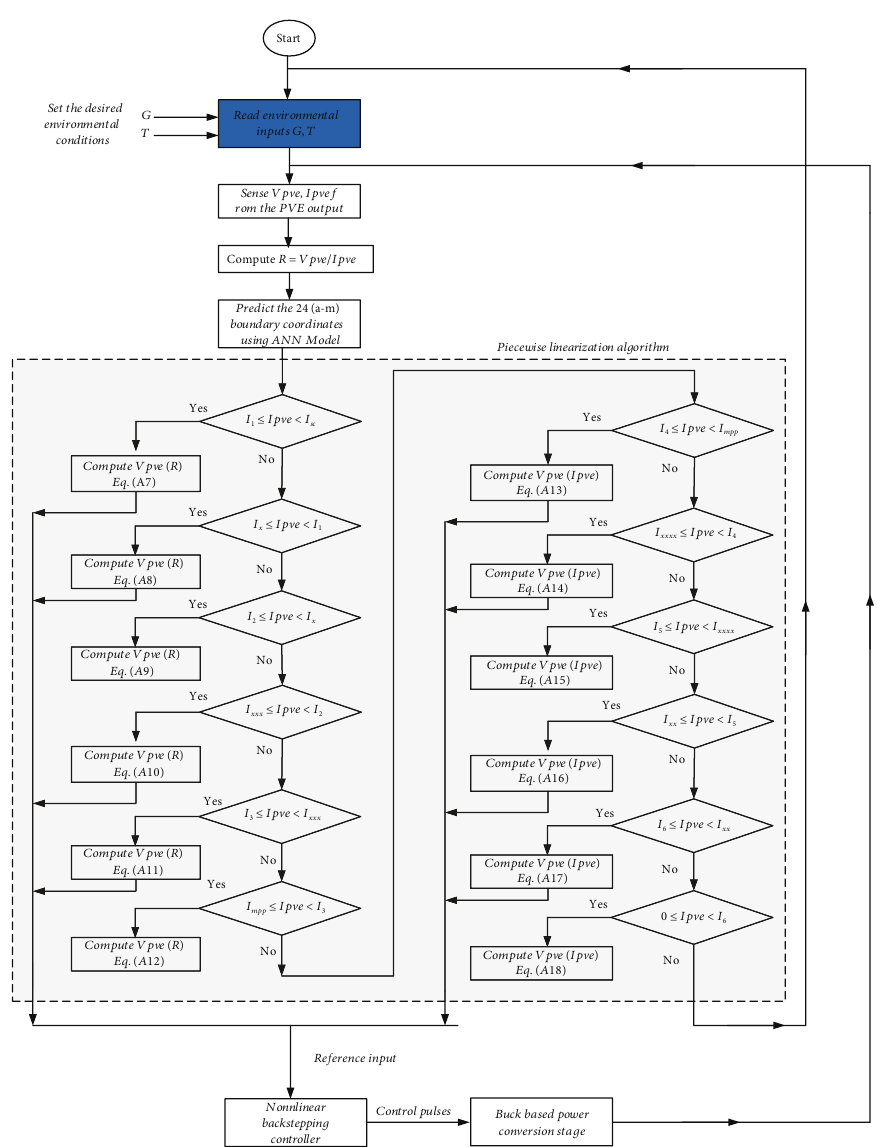
Figure 6: Comprehensive fl owchart algorithm of the proposed photovoltaic